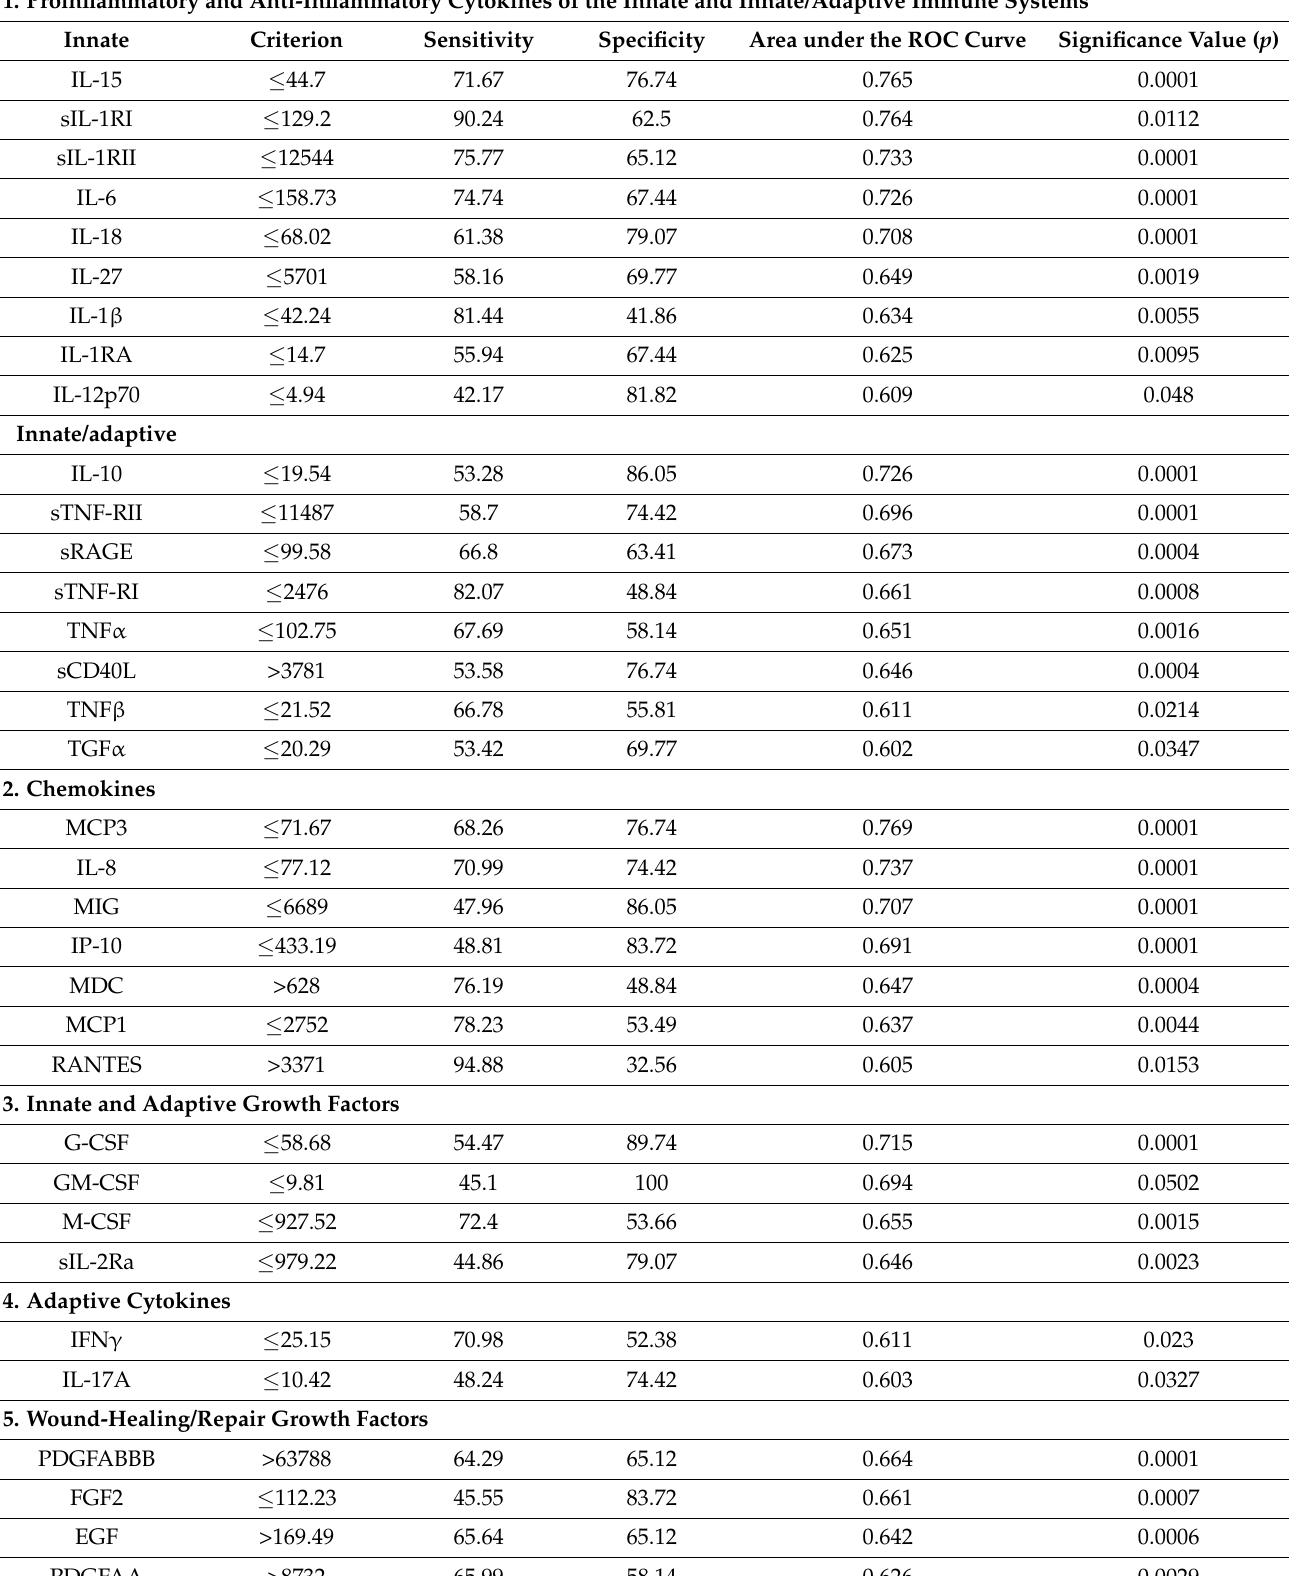
Table 2. Survival predictive analysis of the best serum soluble factor levels included in this study in severe COVID-19